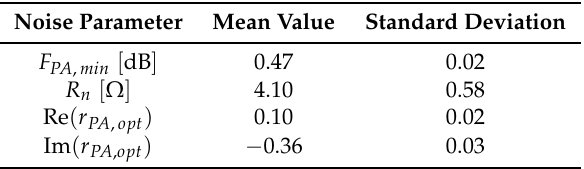
Table 1. Noise parameter mean values and standard deviation of 20 investigated low noise pre-amplifiers.